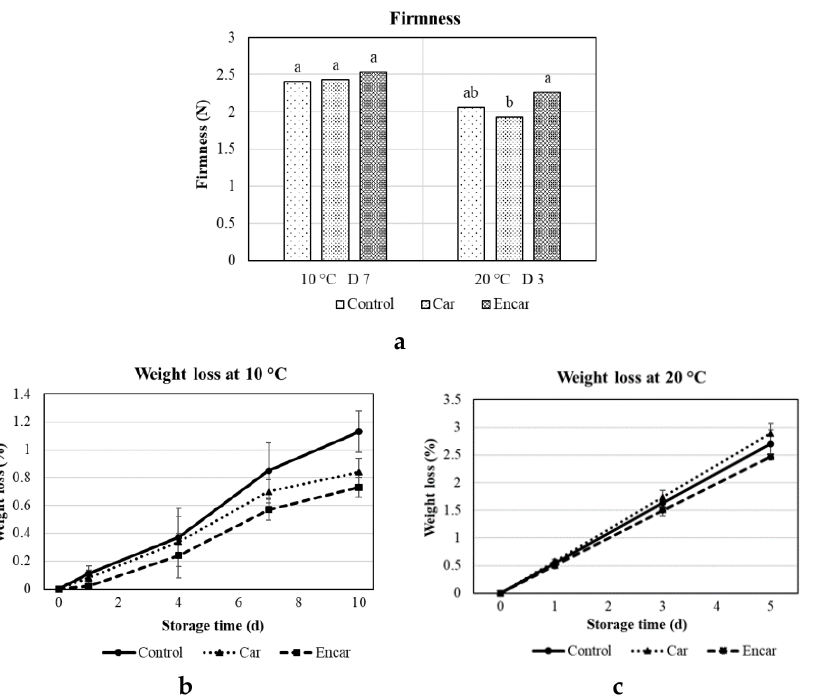
Figure 2. Effects of pectin-sodium alginate microencapsulated carvacrol (Encar) and non-encapsulated carvacrol (Car) on firmness ( a ) and weight loss ( b , c ) of fresh blueberries at 10 °C for up to 10 days, and 20 °C for up to 5 days. Bars with different letters within a storage temperature indicate significant differences using the Student’s t test ( p < 0.05, n = 20).